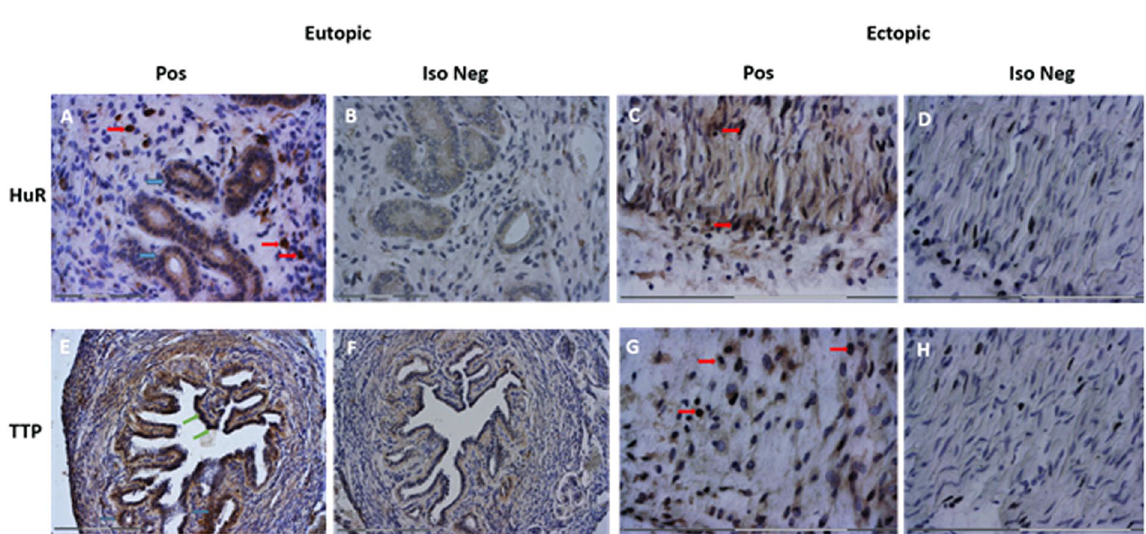
Figure 8. HuR and TTP is immunolocalized throughout the endometrial microenvironment in eutopic and ectopic endometrium from a mouse model of endometriosis. HuR localization patterns were examined in eutopic (Panels A,B) and ectopic (Panels C,D) endometrium. HuR immunostaining was primarily found in glandular epithelium (blue arrows; brown staining prominent in panels A), and endometrial stroma (red arrows, Panels A,C) from both eutopic and ectopic endometrium TTP was localized primarily in glandular epithelium (blue arrows; Panel A), endometrial epithelium and luminal epithelium (green arrows; prominent staining in Panel E compared to isotype negative in Panel F) in eutopic endometrium. High levels of TTP immunolocalization was noted in endometrial stroma in ectopic lesions (Panel G compared to isotype negative Panel H). Images are representative of 5 slides from 6 mice from 2 experiments (n = 3 day 7, n = 3 day 17). Panels A,B original magnification, 100X, scale bar: 75 µ m. Panels C,D,G,H original magnification, scale bar: 300 µ m 200X, Panels E,F original magnification, 40X, scale bar: 300 µ